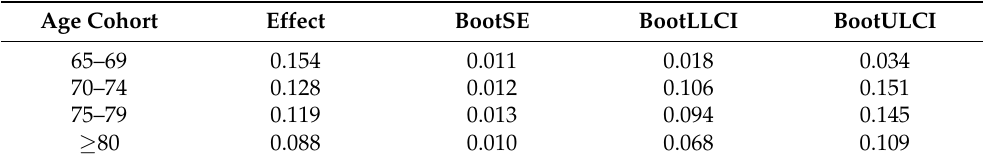
Table 5. Mediating effect values at different levels of age cohorts among older adults in the U.S.,